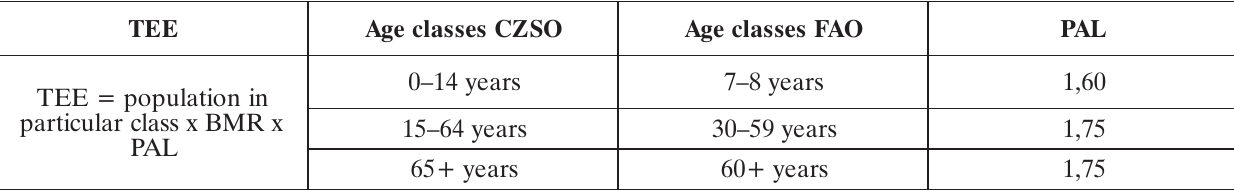
Table 5. Age classification of the Czech population encompassing a level activity assignment